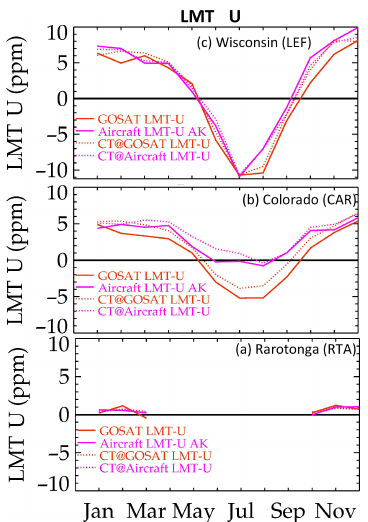
Figure 11. GOSAT LMT – U (red) versus aircraft (pink) at three sites. The dotted lines show CarbonTracker matched to GOSAT (red dotted) or aircraft (pink dotted). Colocation error explains the dis- crepancies in the drawdown at CAR and LEF. At CAR the discrep- ancies are due to mismatch at the time of day the data are collected.